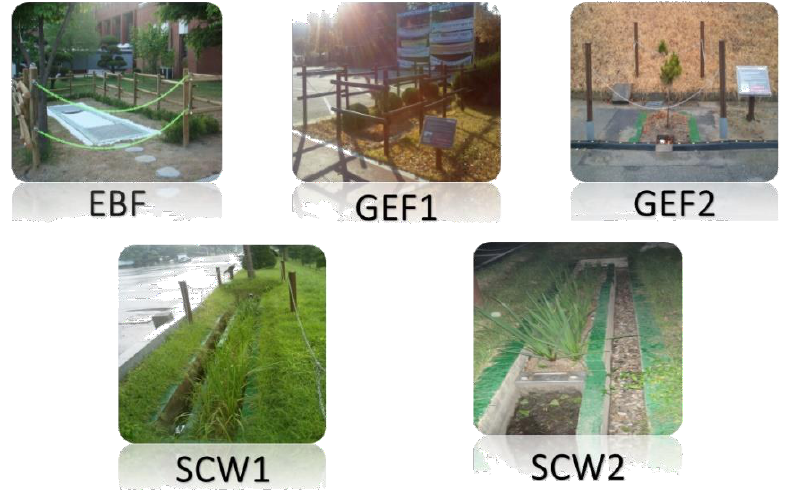
Figure 2. Actual images of the bioretention system.